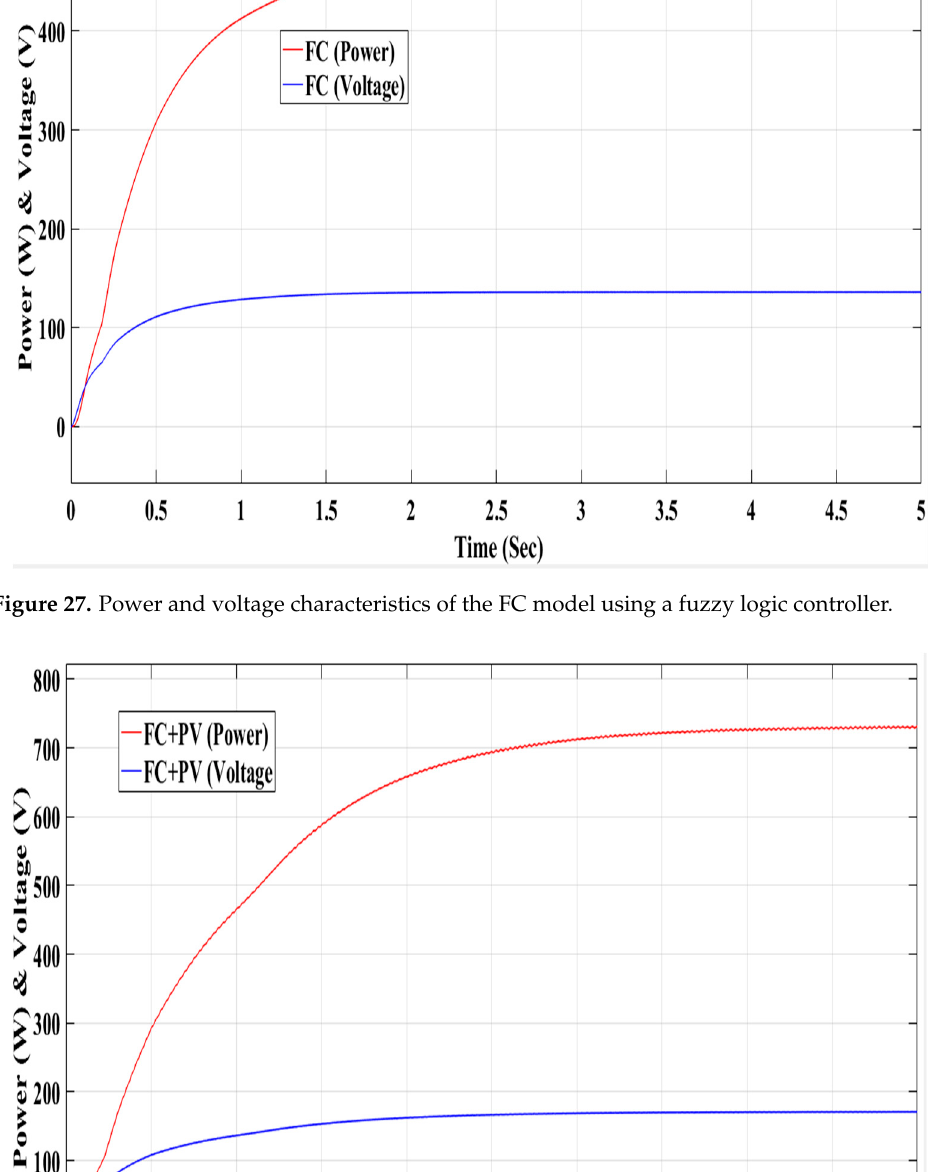
Figure 26. Power and voltage characteristics of the FC–PV–W model using the P&O-based MPPT method.